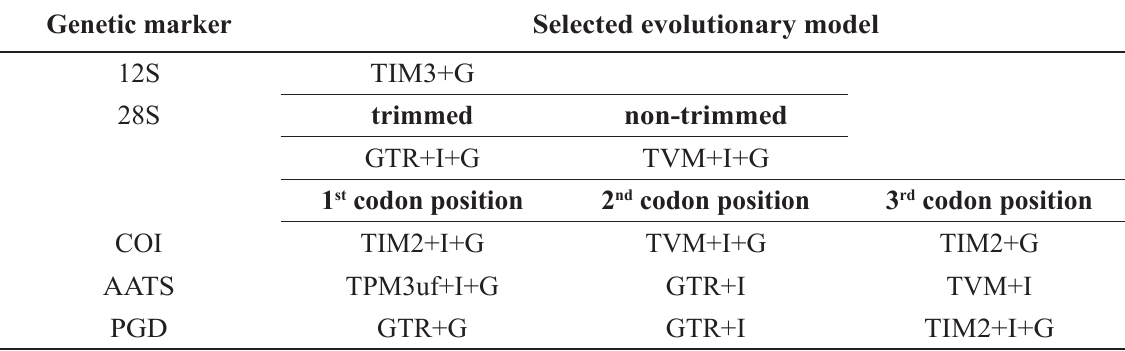
Table 4. Selected evolutionary model to best fit each data partition using jModelTest ver. 2.1.5 under the Akaike Information